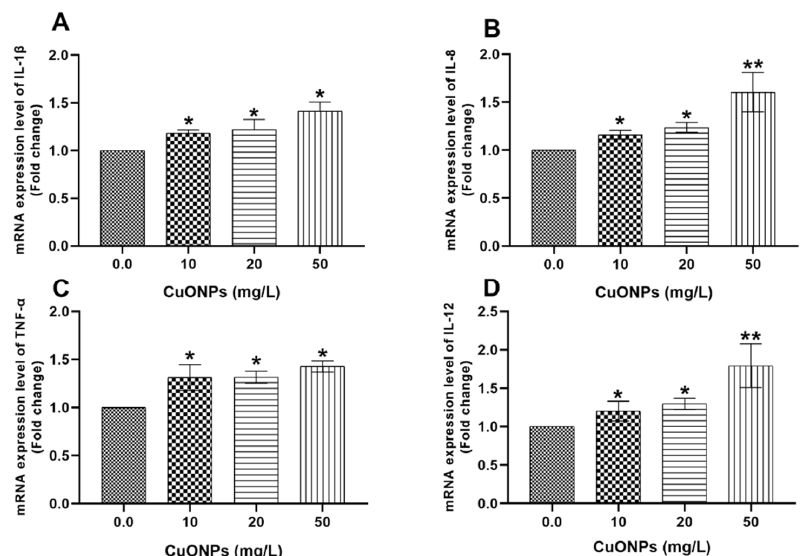
Figure 4. mRNA transcription profile of pro-inflammatory cytokine genes including IL-1 β ( A ), IL-8 ( B ), TNF- α ( C ), and IL-12 ( D ) genes in the hepatic tissues of Nile tilapia juveniles after exposure to sub-lethal concentrations of CuONPs (0.0, 10, 20 mg/L and 50 mg/L) for 25 days. The values are expressed as mean ± SEM ( n = 9). Asterisk (*) ( p < 0.05) and (**) ( p < 0.01) indicate significant differences between the exposure groups compared with the control group. NS indicates non-significant differences.